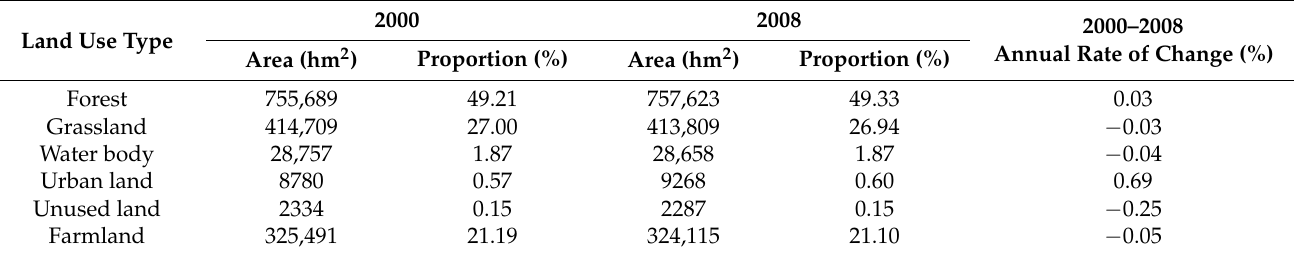
Table 1. Land use structure and single land use dynamics values during 2000–2008.